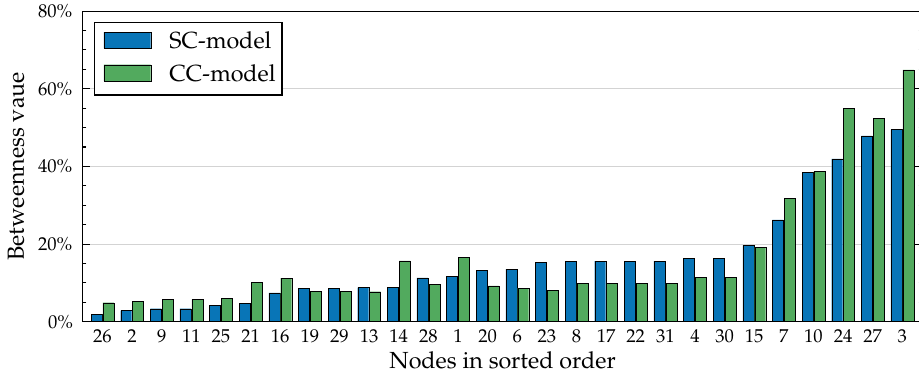
Figure 5. Betweenness values in the Dutch Student network (see Figure 6) with L max → ∞ , λ = 1, T → ∞ , and w ( u , v ) = 0.5 for all ( u , v ) ∈ E . Values are calculated from the influence spreading matrix according to Equation (6). Values are expressed as percentages as our definition of betweenness centrality (Equation (6)) corresponds to the relative change in cohesion (Equation (7)). The higher the percentage, the more important the node.